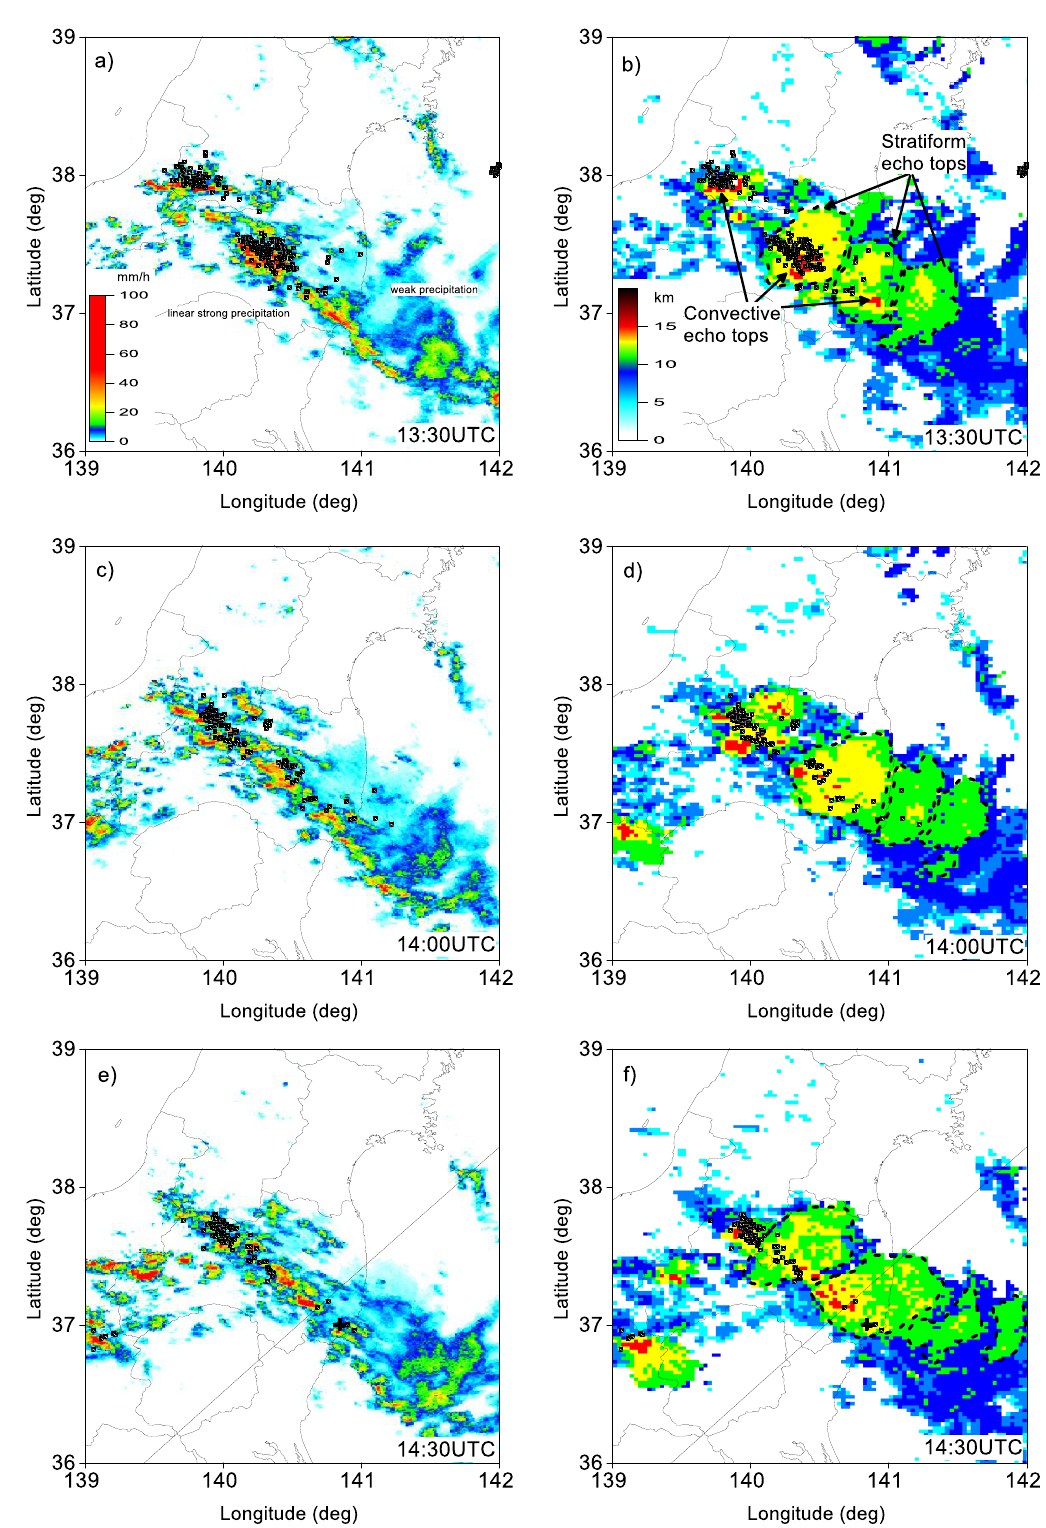
Figure 10. Time evolution of one sprite parent thunderstorm from one hour before Sprite 6. The descriptions ( a – f ) are the same as in Figure 5.